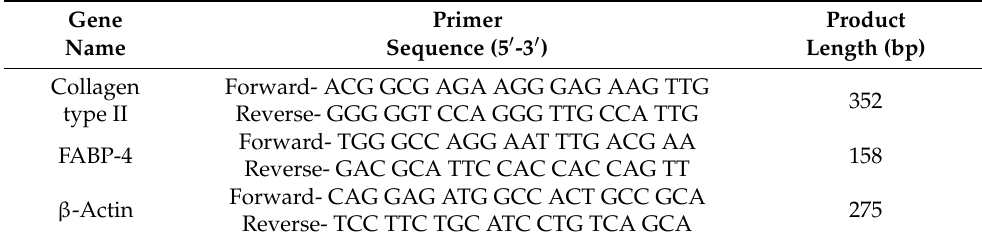
Table 1. PCR primer sets used in this